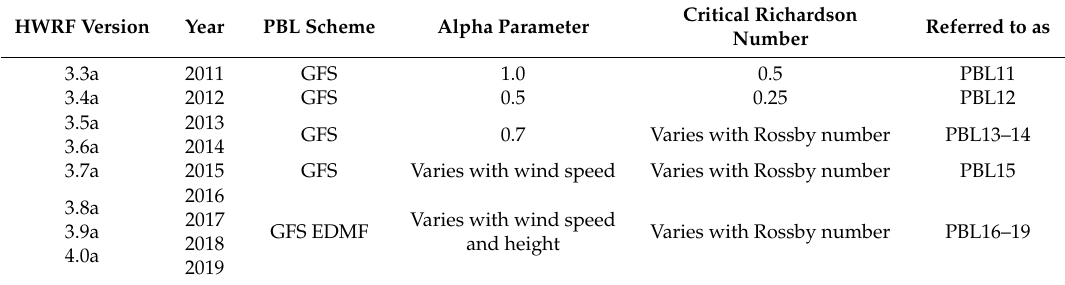
Table 1. Summary of the main di ff erences in di ff erent versions of the planetary boundary layer (PBL) schemes in Hurricane Weather Research and Forecasting model (HWRF). GFS denotes Global Forecast System and EDMF denotes eddy di ff usivity and mass